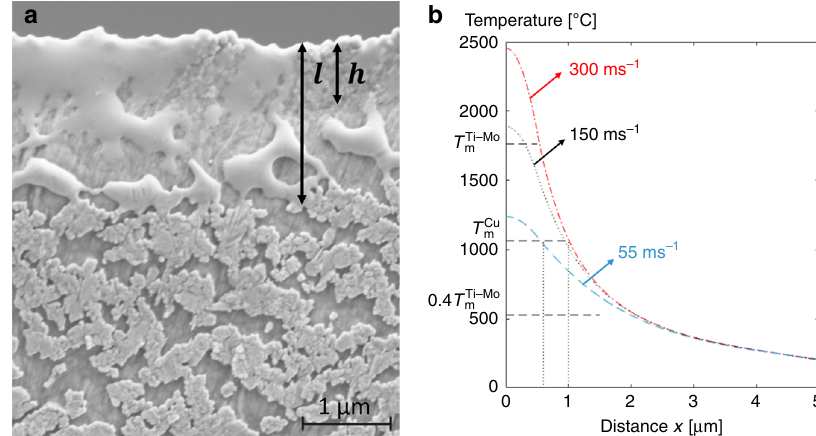
Fig. 5 Temperature rise in the localized band. a SEM micrograph of the Cu coating on the tensile specimen after fracture. The coating melted over a distance l on the fractured specimen. A larger wettability is however observed over a distance h , where the specimen is deformed the most, which demonstrates a different thermomechanical path of this zone from the rest of the sample. b Pro fi les of the highest temperature reached at a normal distance x from the center of the shear band, for shearing speeds of 55 m.s − 1 , 150 m.s − 1 , and 300 m.s − 1 corresponding to coating melted over distances equal to 0.6, 0.9, and 1.0 µ m, respectively. The standard deviation of the measured melted Cu coating lengths (0.6 – 1 µ m) are indicated with the vertical dotted lines.